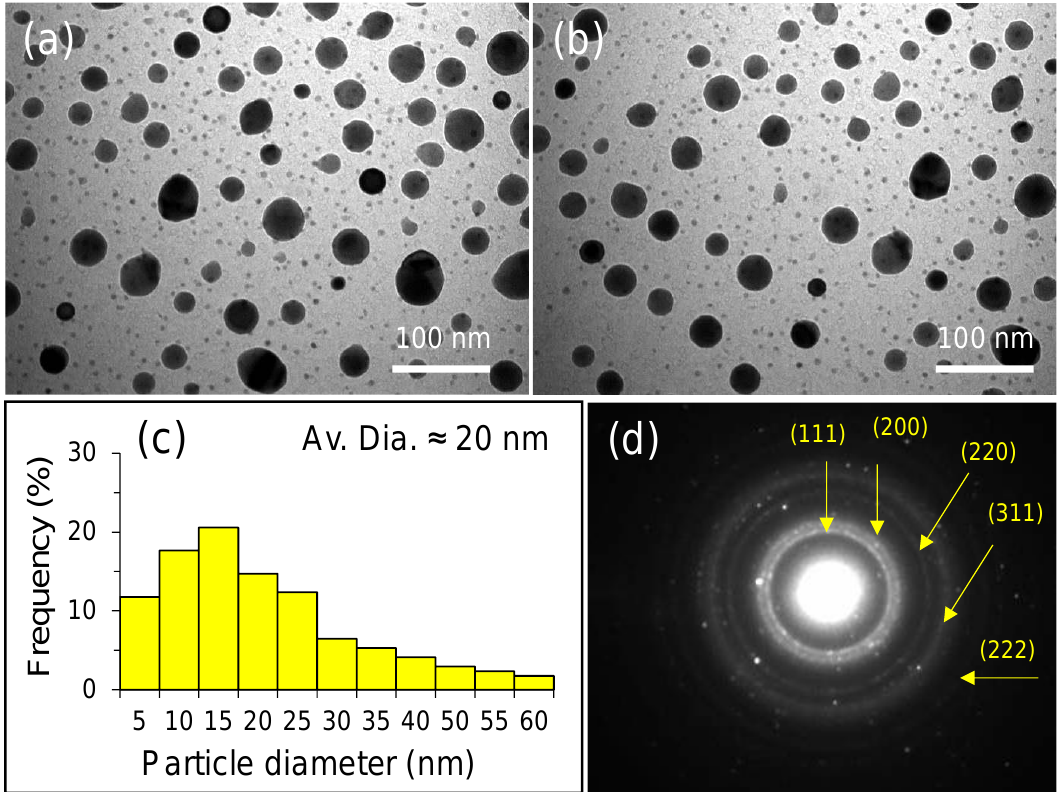
Figure 5. ( a , b ) TEM images, ( c ) size histogram and ( d ) SAED pattern of AP-AgNPs. The average size of the particles was measured around 20 nm. The characteristics rings of the AP-AgNPs are labelled in the SAED pattern.